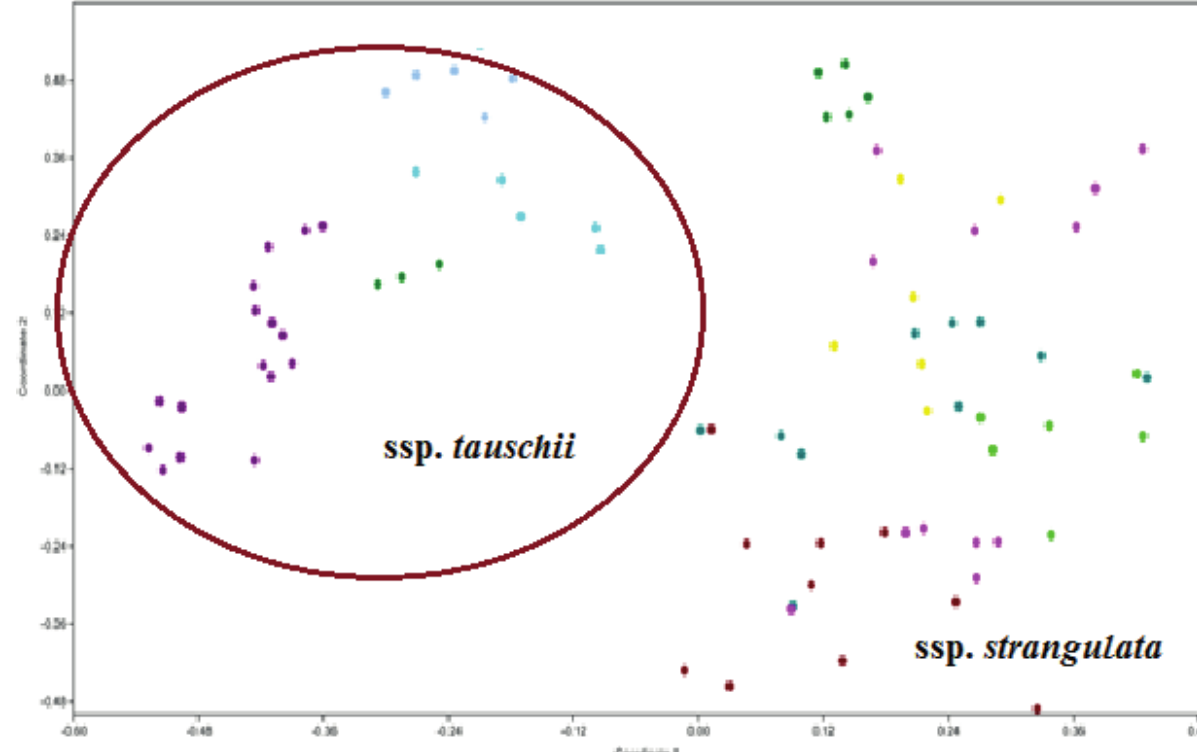
Figure 3. PCoA plot of populations in Ae. tauschii based on SCoT molecular markers, (Population numbers are according to Table 1).